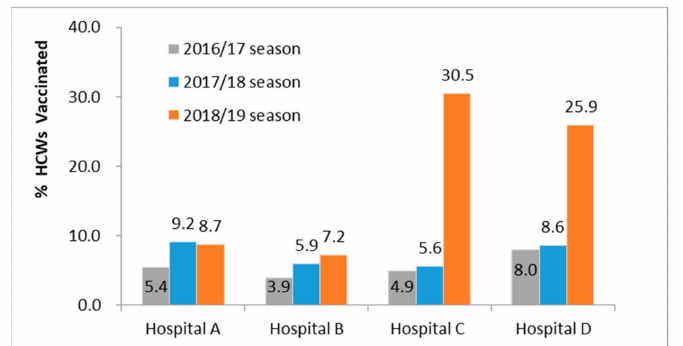
Figure 1. Seasonal-influenza-vaccination coverage in healthcare workers in two hospitals providing free vaccinations and two control hospitals, Xining, China, 2016–2019. Hospitals C and D implemented